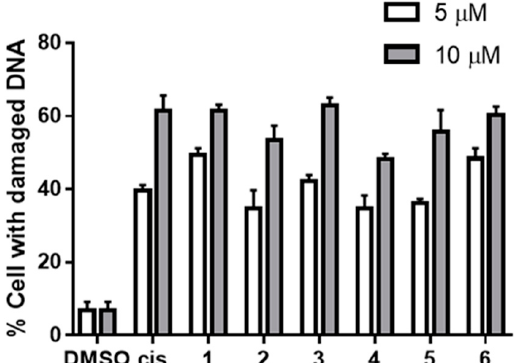
Figure 4. Percentages of PC3 cells with damaged DNAs upon exposure to compounds 1 – 6 at 5 and 10 μ M, referencing cisplatin (cis) at 10 and 15 μ M (white and grey bars, respectively); p ≤ 0.0001 in all treatments.